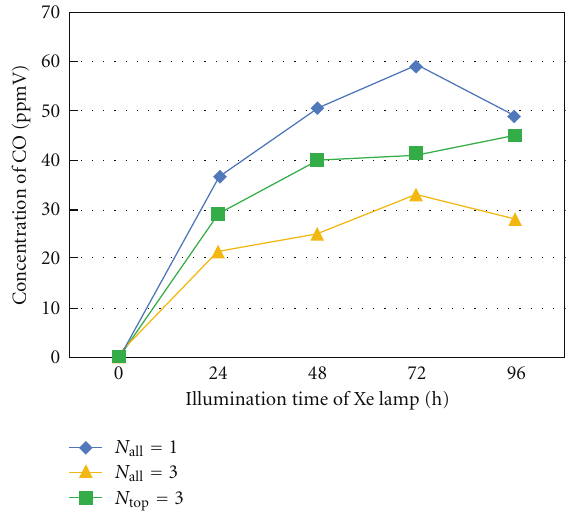
Figure 14: Comparison of concentration change of CO by CO 2 reforming with illumination time of Xe lamp without UV light for N = 1, N = 3 and N = 3. all all top